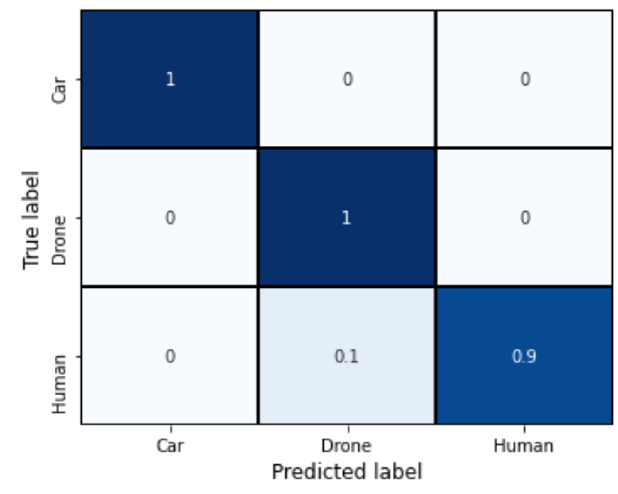
Figure 17. Confusion matrix of LightGBM model on test data.